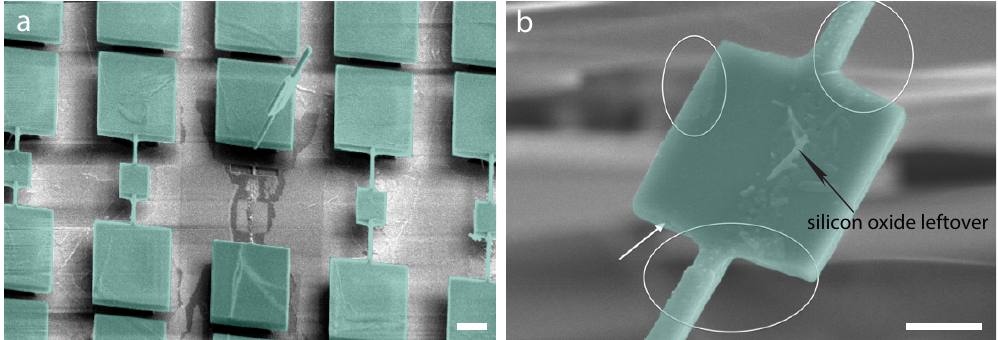
Figure 6. Device (B5) cut to see the nanoparticles on the bottom side. ( a ) False-color SEM image of the cut device. The scale bar is 2.5 µ m. ( b ) False-color SEM image of the cut device on the bottom side. The white arrow indicates the oxide layer surface on the bottom side. The encircled areas show a small number of nanoparticles at the edges. The scale bar is 1.2 µ